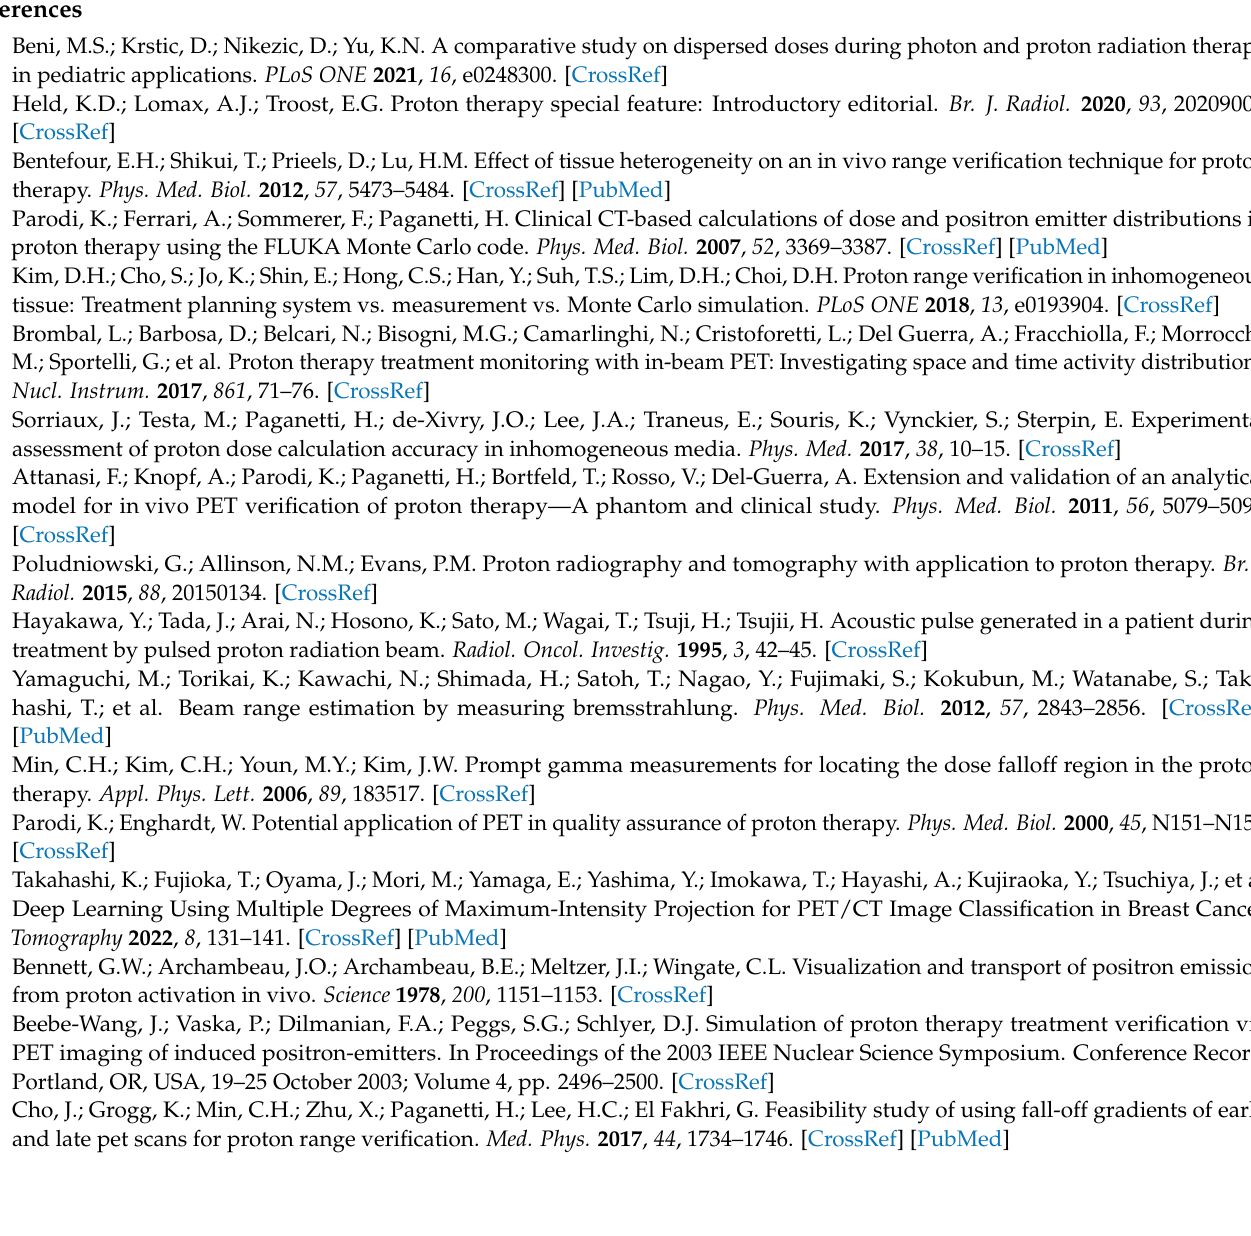
Figure A1. The unnormalized 1D profiles of the simulated depth-dose of protons and production of positron emitting radionuclides ( 15 O, 11 C, and 13 N) in ordinary slab phantom for ( a ) pristine and ( b ) SOBP incident proton beams.